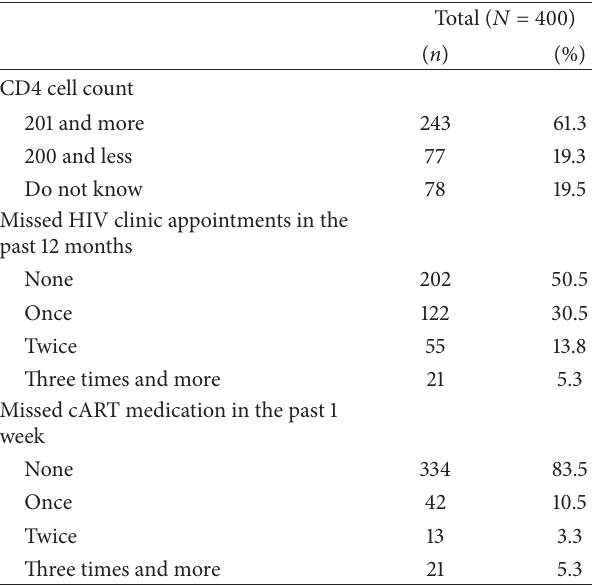
Table 1: Patient sociodemographics and health status characteris-